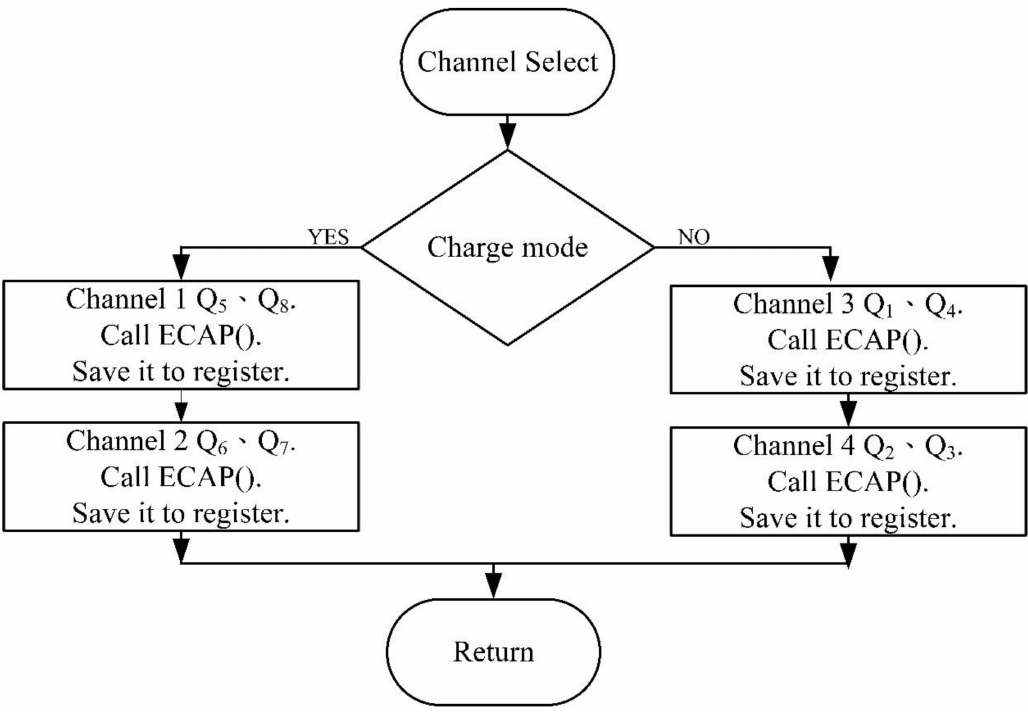
Figure 12. Flowchart of the Channel Select subroutine.